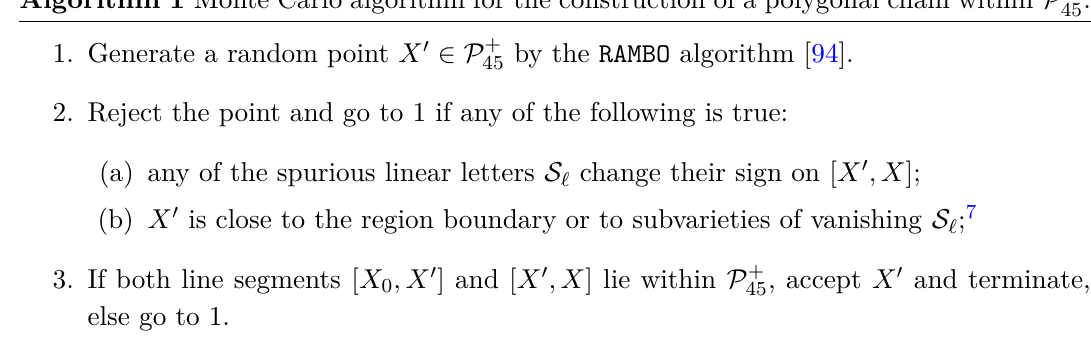
Algorithm 1 Monte Carlo algorithm for the construction of a polygonal chain within P + 45